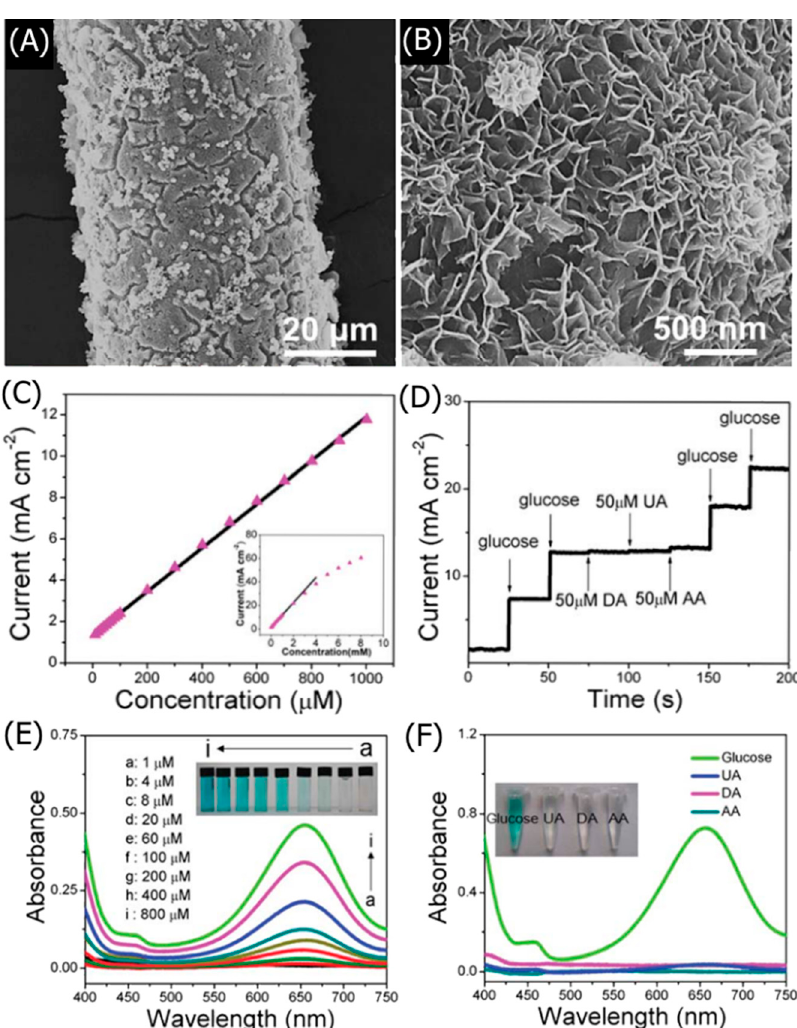
Figure 6. SEM micrographs of the CoFe-LDH at ( A ) low and ( B ) high magnifications; ( C ) calibration of the CoFe-LDH sensor for glucose detection for the linear portion and the complete calibration curves (insert); ( D ) chronoamperometry with glucose, DA, UA, and AA for interference studies. Change in absorbance with increasing glucose concentration from 1 to 800 µ M ( a – i ). Optical selectivity for glucose against UA, DA, and AA ( E ) UV-vis spectra and photographs for the CoFe-LDH colorimetric system with different glucose concentrations; ( F ) Selectivity tests of the CoFe-LDH colorimetric system ([DA] = [AA] = [UA] = 5 mM, [glucose] = 2 mM), reproduced from reference [122] with permission from The Royal Society of Chemistry,